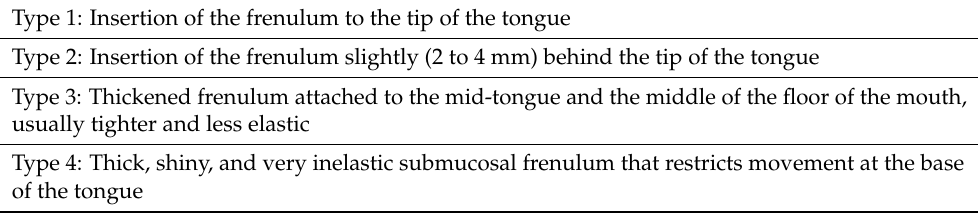
Table 1. Types of Coryllos ankyloglossia